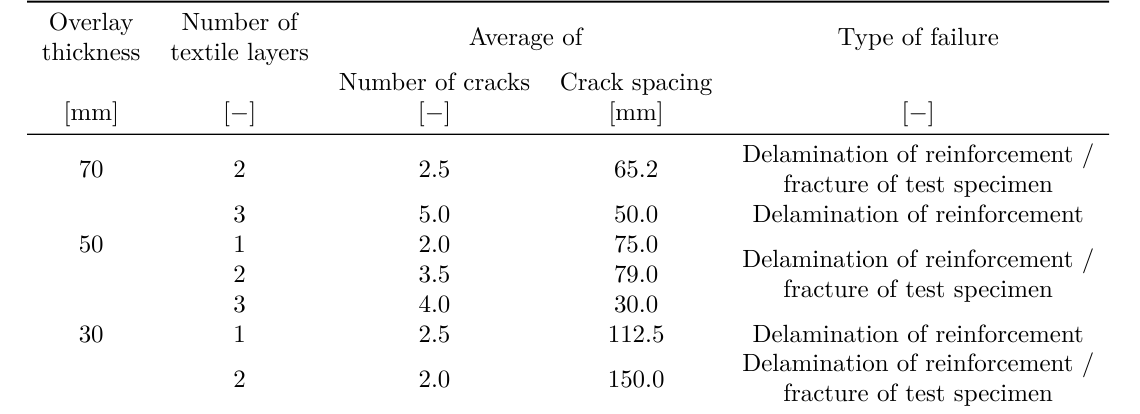
Table 2. Average number of cracks and crack spacing above bond breaker.